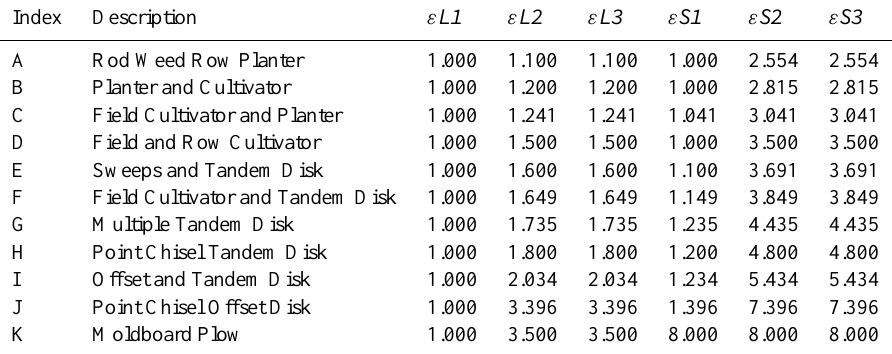
Table 2. Cultivation events and their corresponding decomposition enhancement factors for litter ( εL) and soil C ( εS) . Litter and soil are indexed in order from labile to more recalcitrant C pools for three litter pools (metabolic, cellulose, and lignin) and three soil pools (active, slow, and passive). DayCent combines cellulose and lignin into a single structural litter pool. Site-specific schedule files prescribe the timing of events in each year (Table 3) in CLM and DayCent